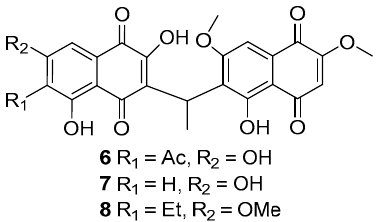
Figure 2. Structures of known naphthoquinone dimers 6 – 8 .